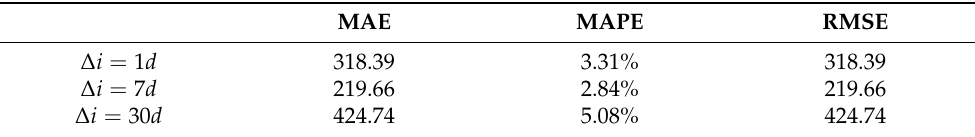
Figure 3. Load forecasting based on persistence method. Table 4. The experimental error of persistence method.